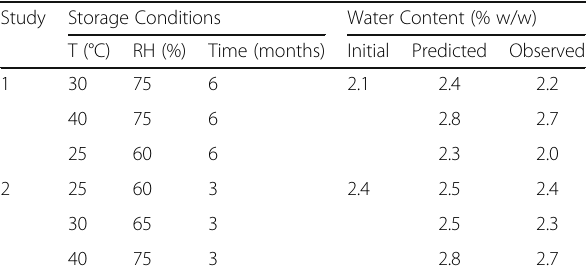
Table 4 Predicted and observed water content of tablets packaged in Aclar® foil blisters at different storage conditions (Temperature (T) and Relative Humidity (RH)) Study Storage